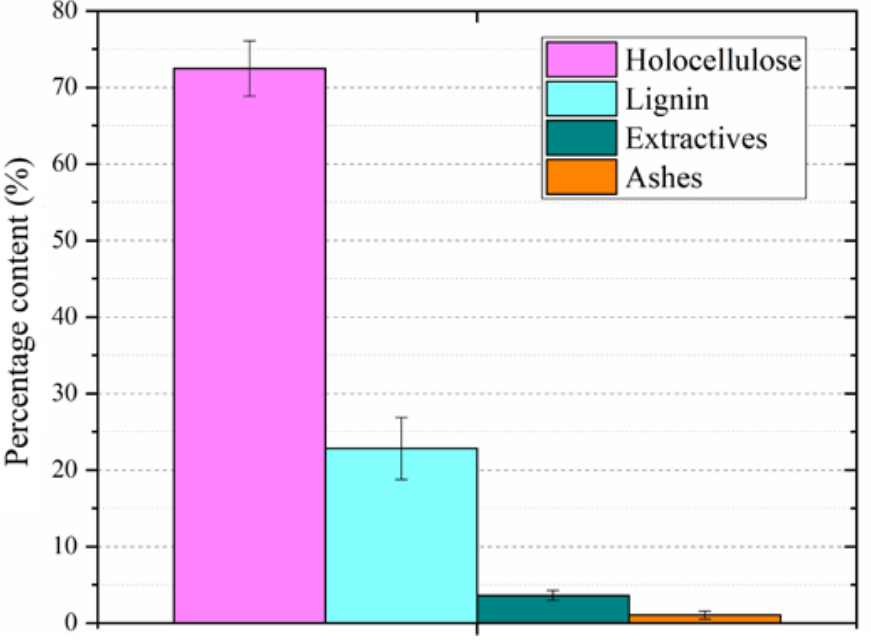
Figure 1. Chemical constitution of the wood flour.